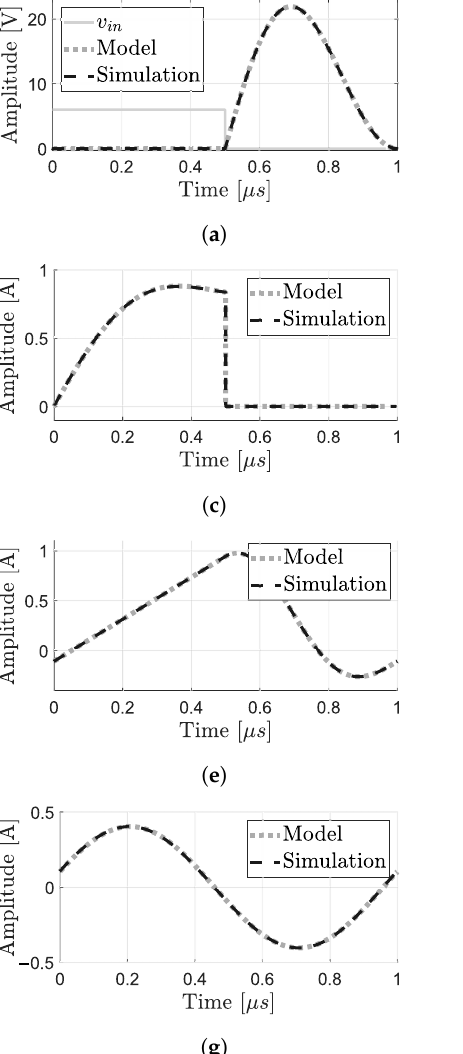
of amplifier ID 1. ( b ) v S W of ID 6. ( g ) i R SH